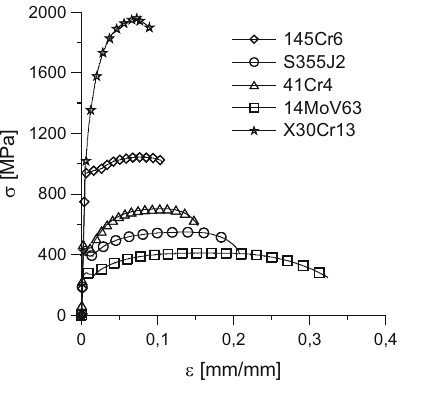
Figure 2: Engineering tensile diagrams σ = f ( ε ) for materials used in the analysis ( based on refs. [ 9 – 12 ]) .